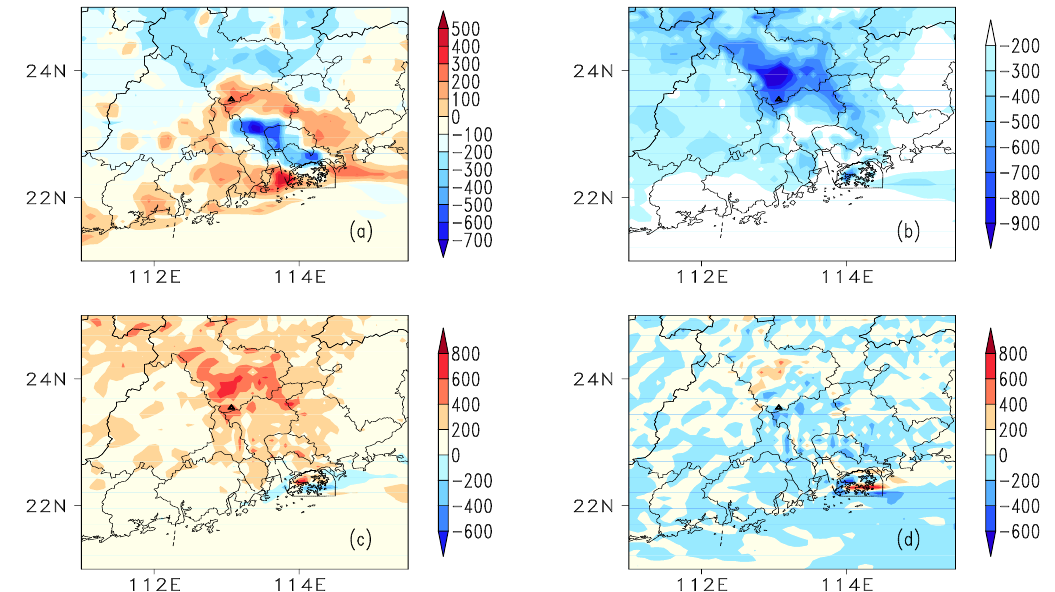
Figure 4. Spatial distribution of physical and chemical contributions to averaged PAN concentrations at noon time. ( a ) Gas-phase chemical process, ( b ) dry deposition, ( c ) vertical transport, ( d ) horizontal transport; black triangle highlights the position of BGS. To more clearly present the variations in the contributions of different process, the negative values in the figure represent corresponding processes that made contributions to the removal of PAN, while positive values represent corresponding processes that could increase PAN levels at the sampling site.